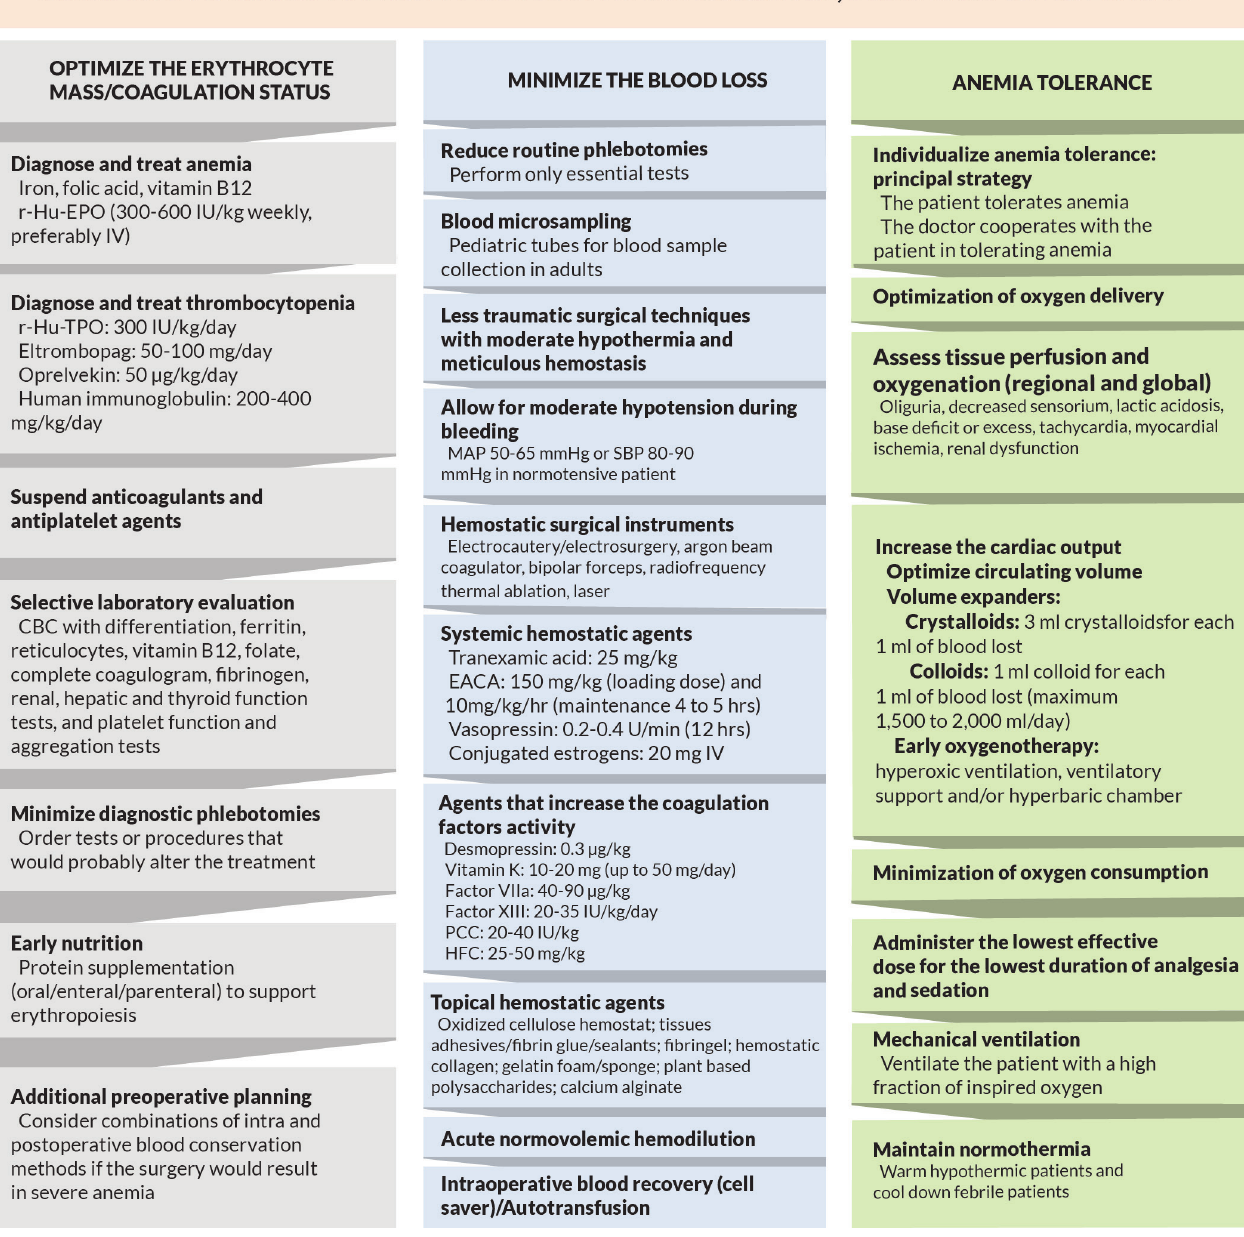
Fig. 2 - Flowchart with strategies to minimize allogeneic blood transfusions and their adverse effects. CBC - Complete blood count; EACA - epsilon aminocaproic acid; Factor VIIa - Recombinant activated factor VII; HFC - Human fibrinogen concentrate; IV - Intravenous; MAP - Mean arterial pressure; PCC - Prothrombin complex concentrate; r-Hu-EPO - Recombinant human erythropoietin; r-Hu-TPO - Recombinant human thrombopoietin; SBP - Systolic blood